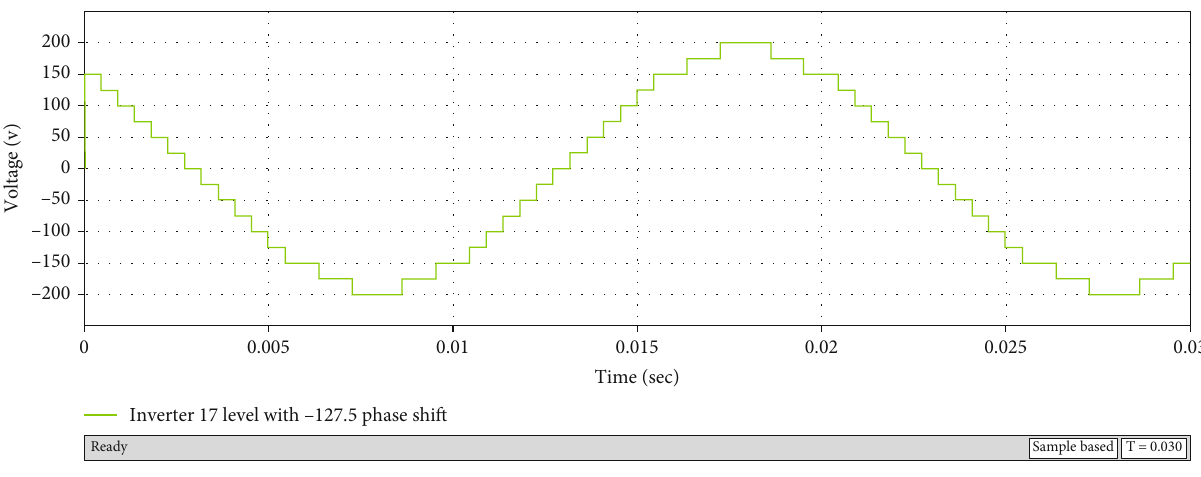
Figure 30: 17-level MLI with t = 0 : 03 for phase b.